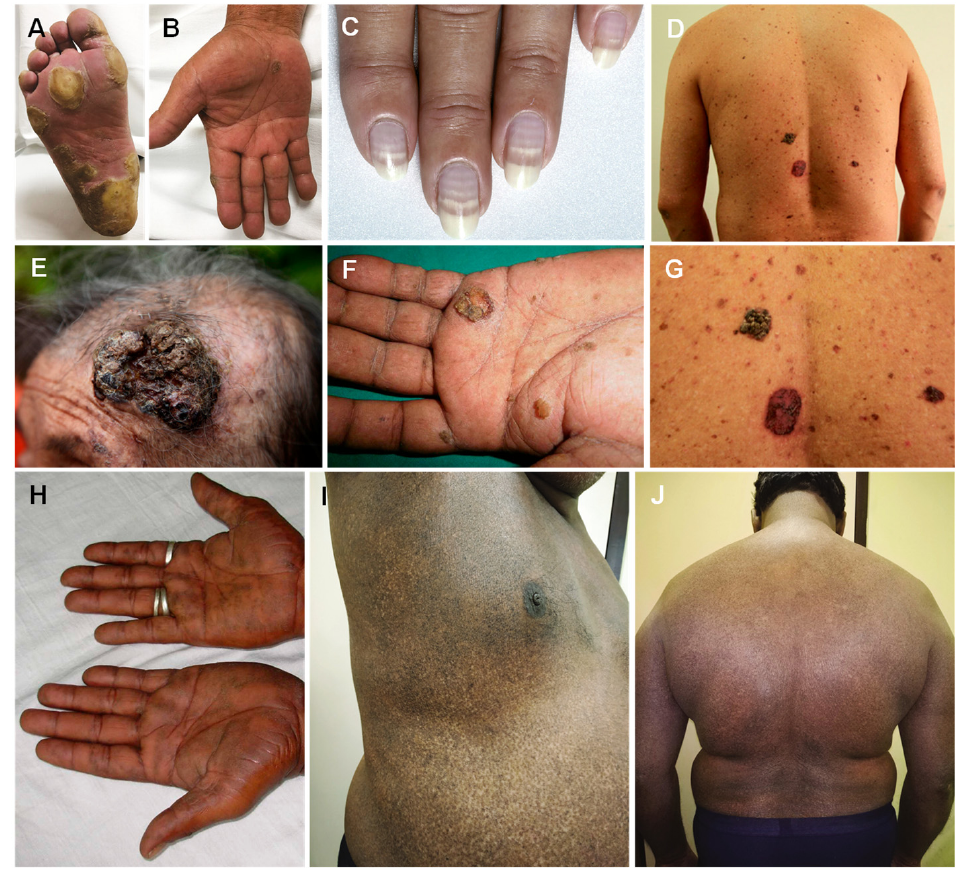
Figure 2. Hyperkeratosis of soles ( A ) and palms ( B ), Mee’s lines ( C ), diffused hyperpigmentation on the trunk ( D ), Bowen’s disease on head ( E ) and palm ( F ), hyperkeratosis on the trunk ( G ), palmar pits ( H ), and raindrop pigmentation ( I , J ). Reprinted from ( A , B )—[70], ( C )—[71], ( D , E , G )—[72], ( F , H )—[69], ( I , J )—[73].